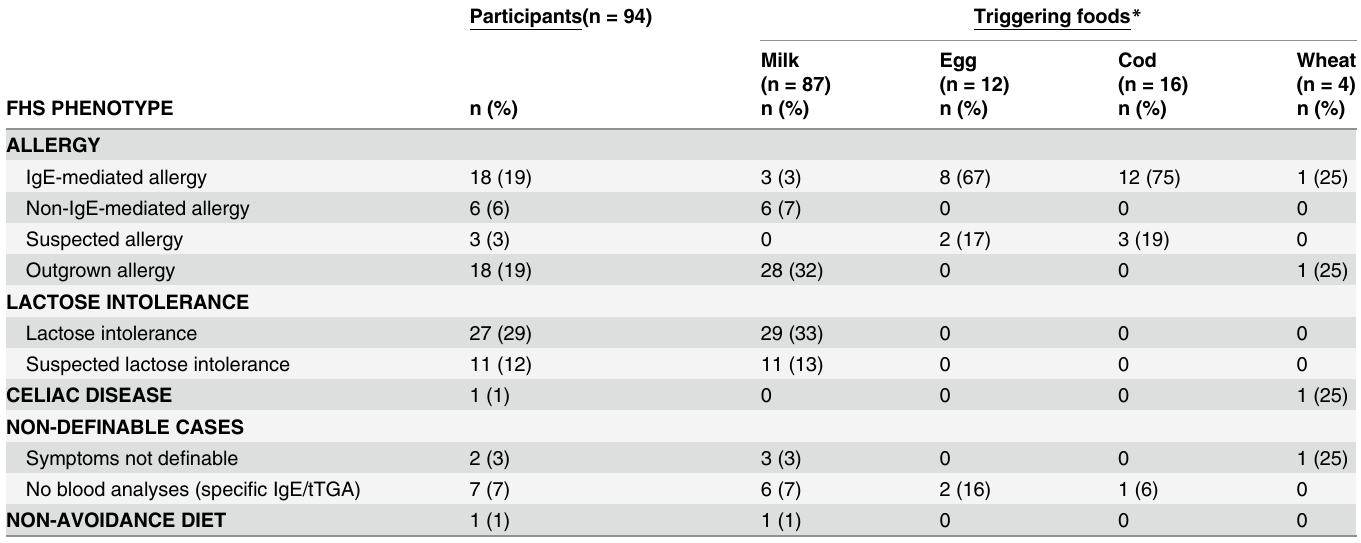
Table 1. Distribution of phenotypes of food hypersensitivity (FHS) based on the clinical examinations, and the relation to the individual triggering